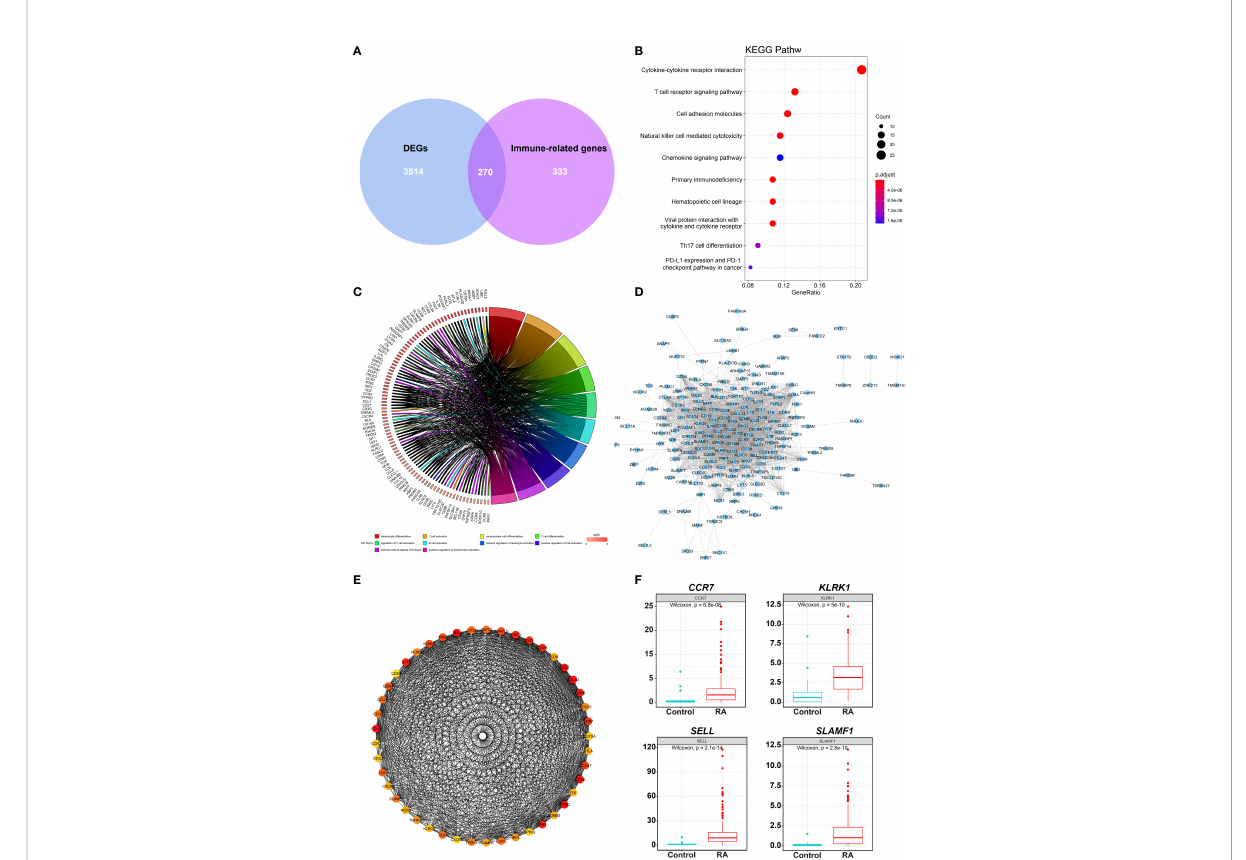
FIGURE 3 DEIRGs screening and enrichment analysis. (A) Venn diagram of 270 overlapped candidate genes shared by DEGs and Immune-related genes (MEyellow module). KEGG (B) and GO (C) enrichment analysis showed the most signi fi cantly enriched pathways. (D) Protein-protein interaction (PPI) analysis by STRING database for 270 DEIRGs. (E) PPI diagram of all the genes in cluster 1. (F) Expression levels of 4 potential biomarkers between RA and HC